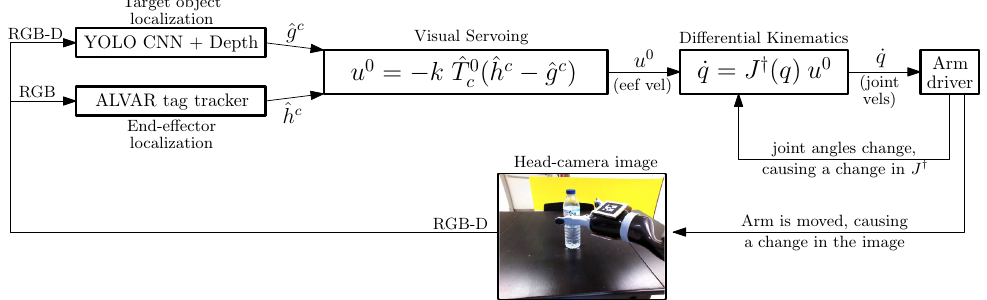
Figure 6. Diagram of the visual servoing architecture for reaching and grasping